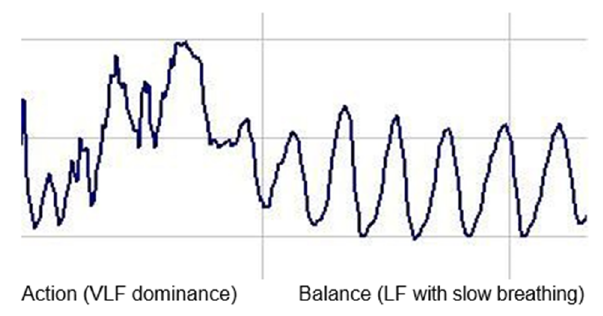
Figure 1. HRV (Heart Rate Variability) patterns (tachogram). Autonomic Balance is the marker of the state of the ANS. Unconscious perception of safety is reflected in higher HF values, while threat produces HF (vagal) withdrawal and sympathetic activation. Autonomic balance is defined in terms of complex heart rate (HR) patterns that increase and decrease in response to respiratory fluctuations (Figure